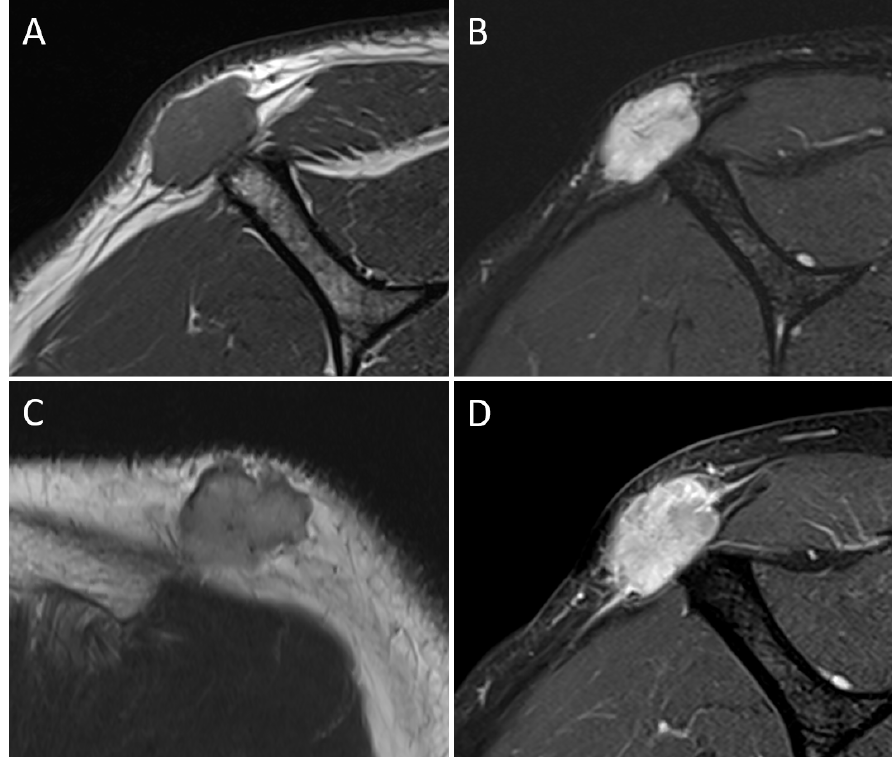
Figure 2. The sagittal view of the shoulder shows the lobulated mass with low signal intensity on T1-weighted images ( A ), and high signal intensity on fat-suppressed T2-weighted images ( B ). On T2-weighted images, the lesion is intermediate signal intensity but higher than the adjacent muscle ( C ). The lesion shows intense enhancement with adjacent fascial thickening ( D ).